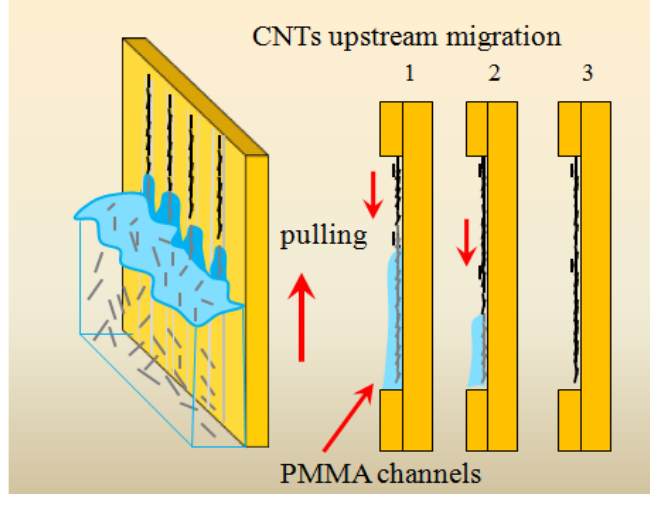
Figure 12. Schematic illustration of single walled carbon nanotubes (SWCNT) aggregation and assembly in channels by capillary induced flow, where the left vertical arrow denotes the template pulling direction and the two right ones represent the sweeping direction of the liquid–solid contact line in poly(methyl methacrylate) (PMMA) channels (Reproduced with permission from [36]. Copyright 2007 Wiley-VCH Verlag GmbH & Co.